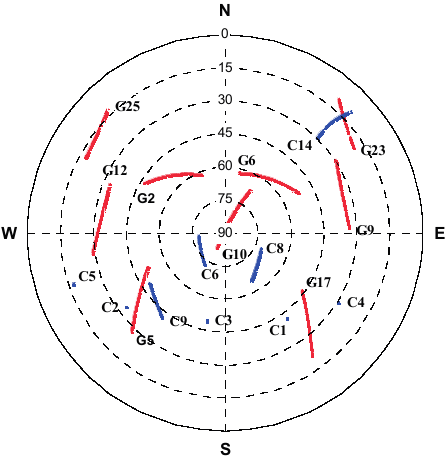
Figure 5. Sky plots of GPS/BeiDou satellites during the field test.